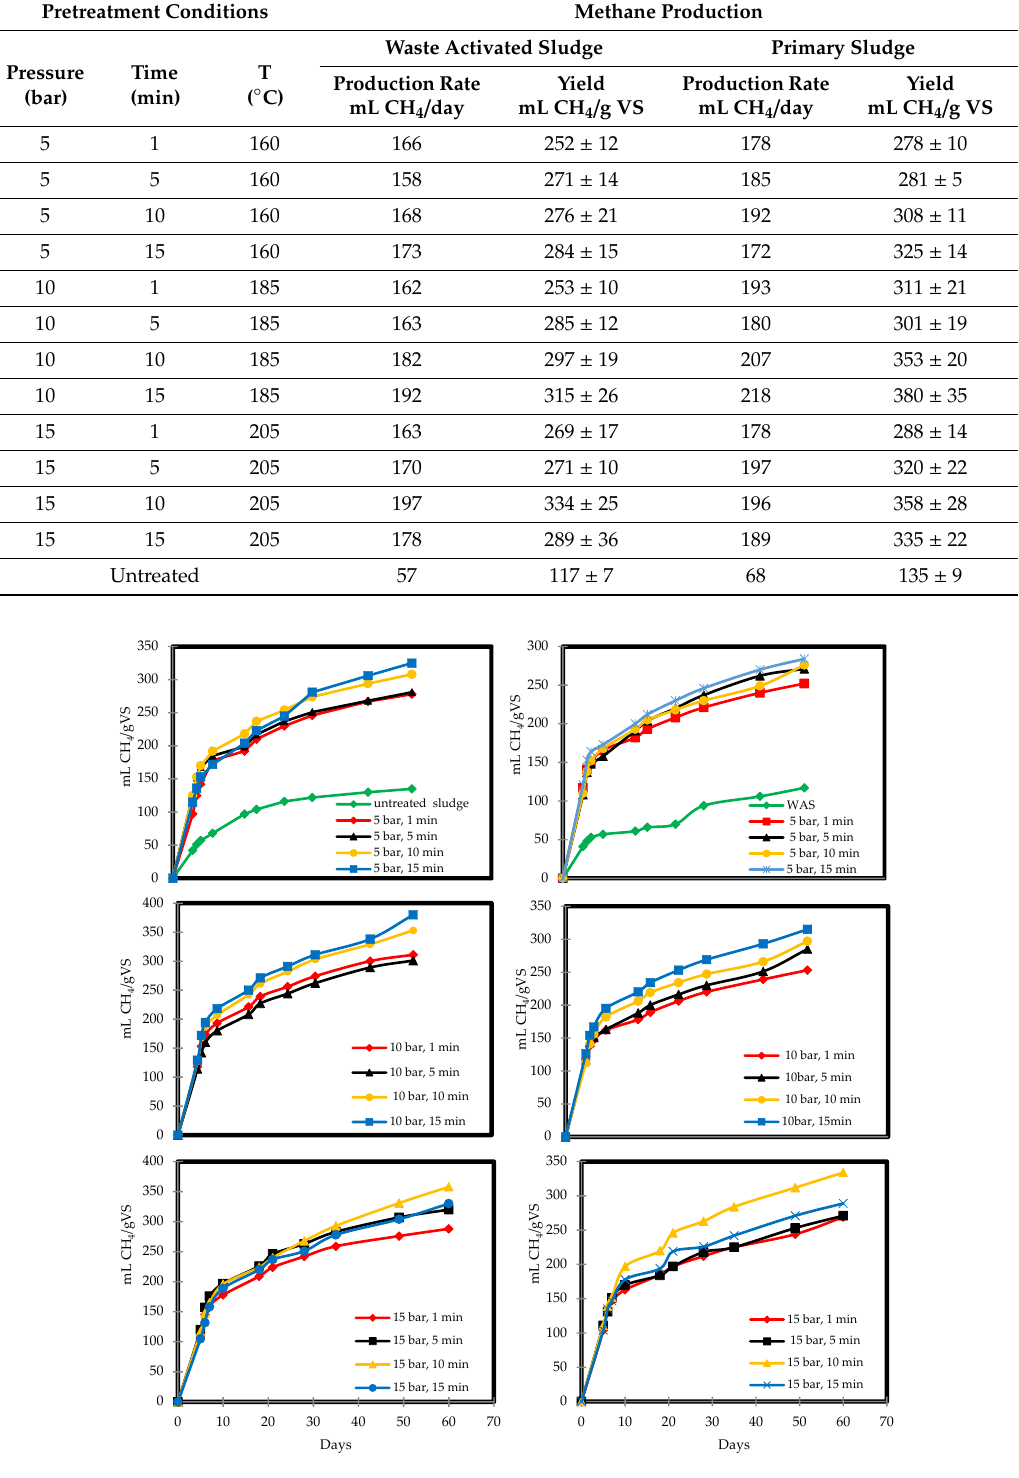
Figure 5. Cumulative methane production during anaerobic digestion from PS and WAS pretreated by steam explosion.